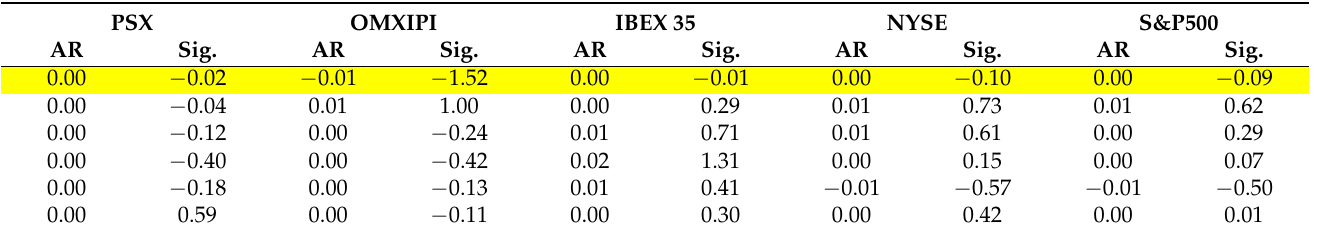
Table A34. Abnormal returns of the (0, +5) event window (Resignation of D. Jos é Manuel Soria, Spain’s Minister of Industry).